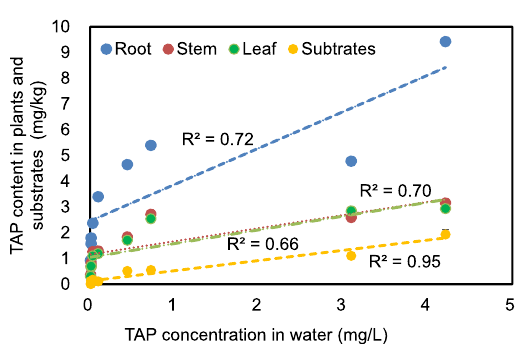
Figure 5. The correlation between TAP content in tissues of Canna indica and that in the substrates, as well as the TAP concentration in water from the sampling ports of the horizontal flow constructed wetlands (HSCWs) fed with mean influent TAP concentrations of 0.12 ± 0.04 mg L − 1 (CW1), 0.79 ± 0.29 mg L − 1 (CW2) and